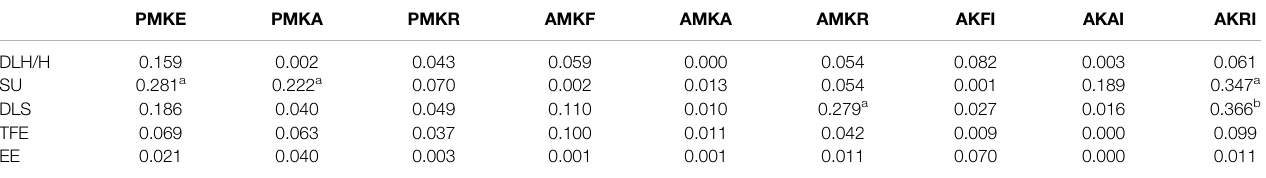
TABLE 3 | Shared variance ( R 2 ) between core-related measurements with kinematic and kinetic measurements during the DJ landing PMKE PMKA